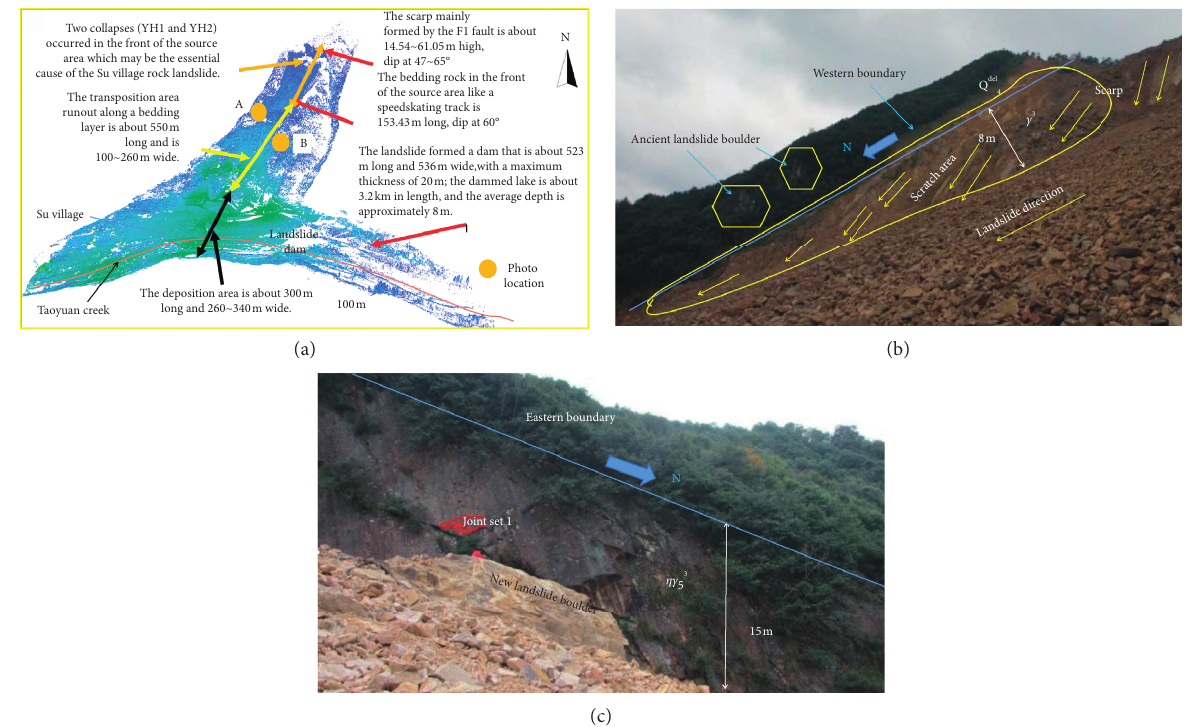
Figure 8: Photograph by a 3D laser scanner and the transposition boundary. (a) 3D laser scanner topography. (b) Western boundary of the landslide with some scratches and fresh-cut steep slope. (c) Eastern boundary of the landslide with well-developed joints and a fracture that is nearly parallel to the slide.